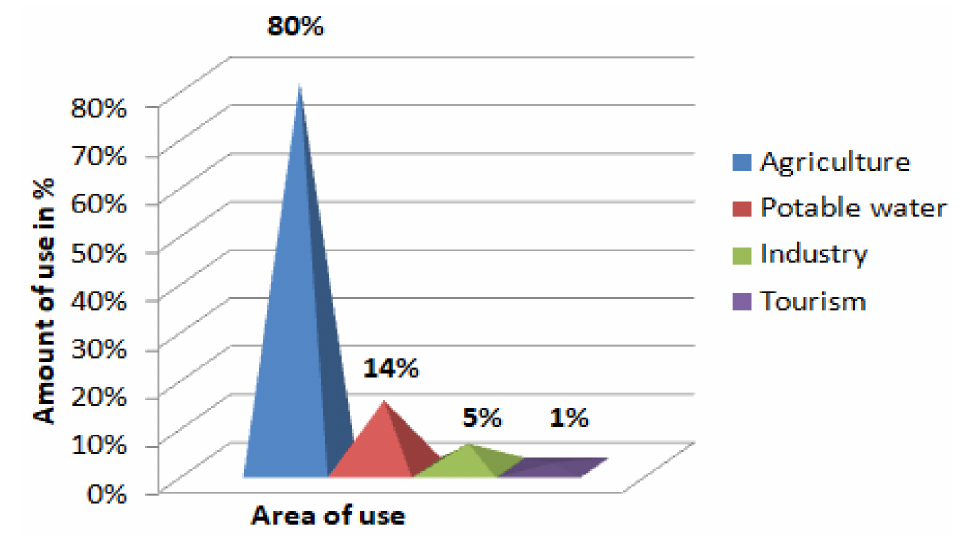
Figure 1. Tunisian water demand repartition.